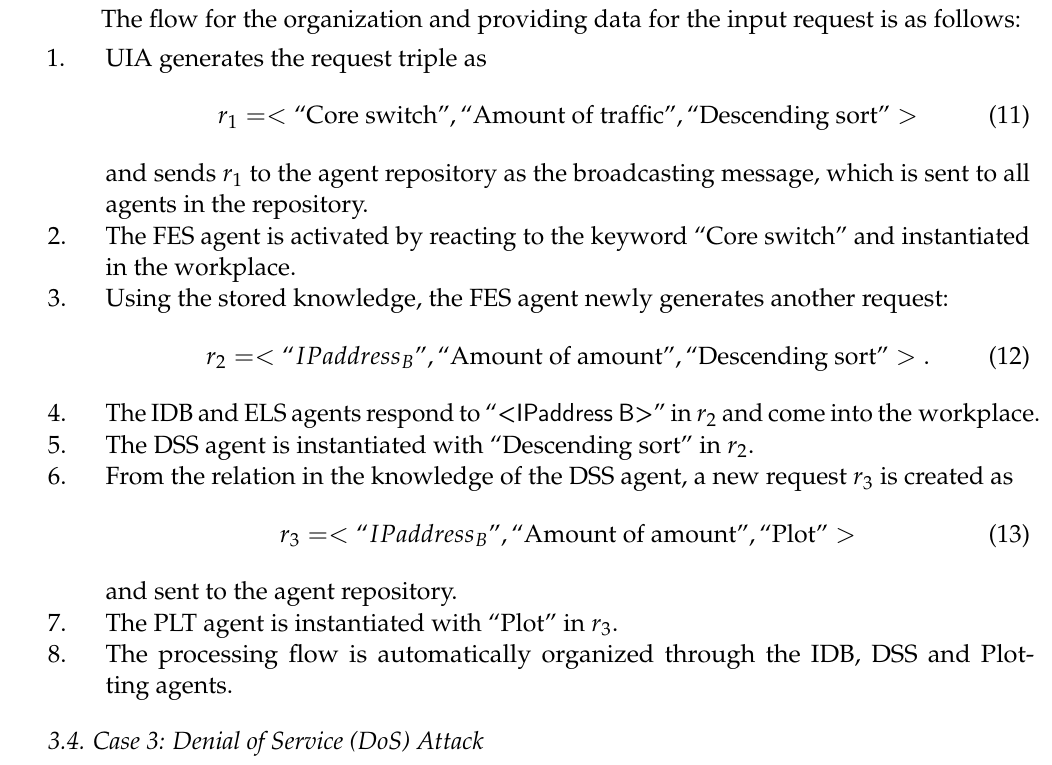
Figure 13. Example result for the prototype system in Case 2. We assert two remarkable results: ( a ) the amount of traffic on the host with IPaddress B and ( b ) the wiki page includes the word “core